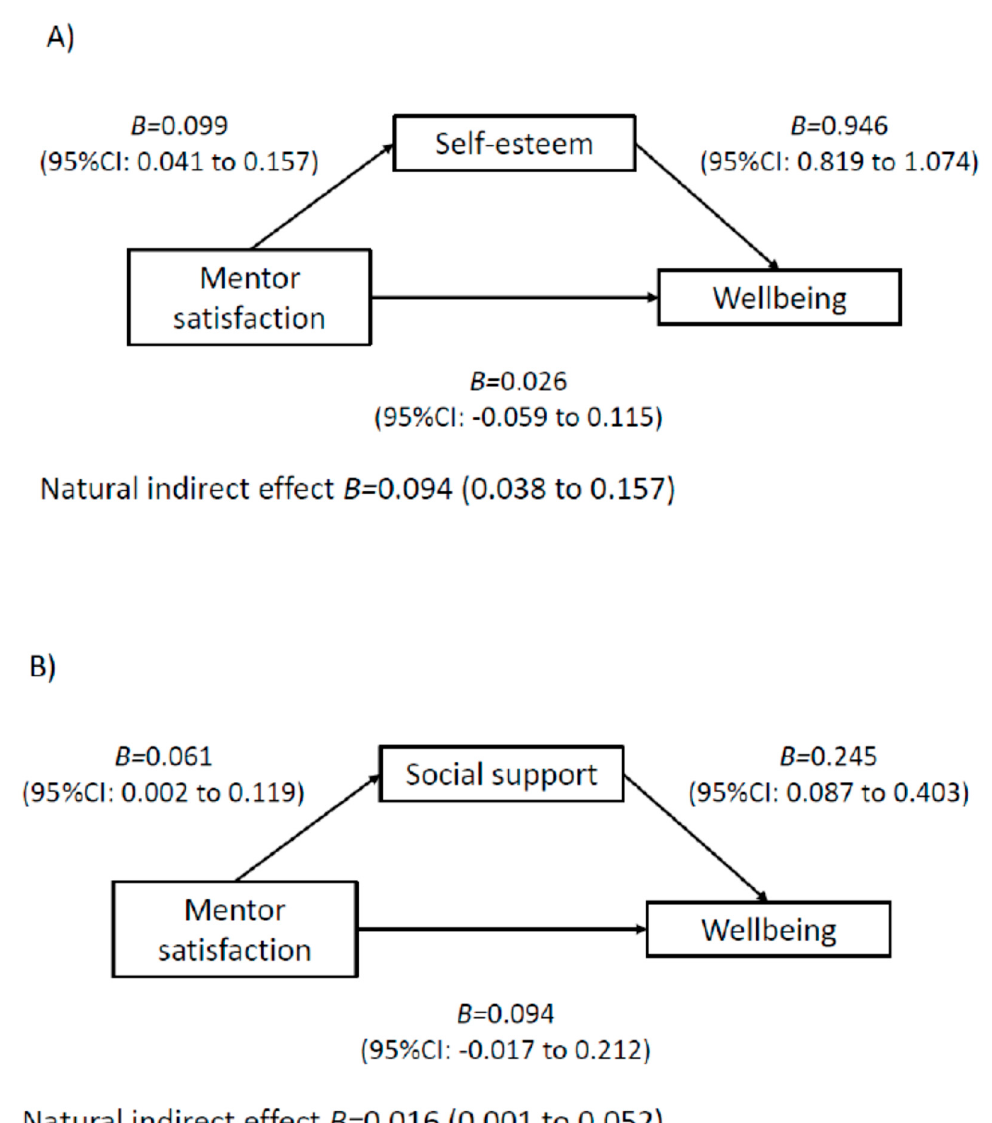
Figure 3. Mediation models of potential psychological mediators in the association between intervention components and wellbeing among girls. Note. Adjusted for age, ethnicity, language, school, BMI z-score and baseline values of change variables. CI, confidence interval. E-values estimates (in relative risk): Model A : E-value: 1.51, Model B : E-value: 1.16